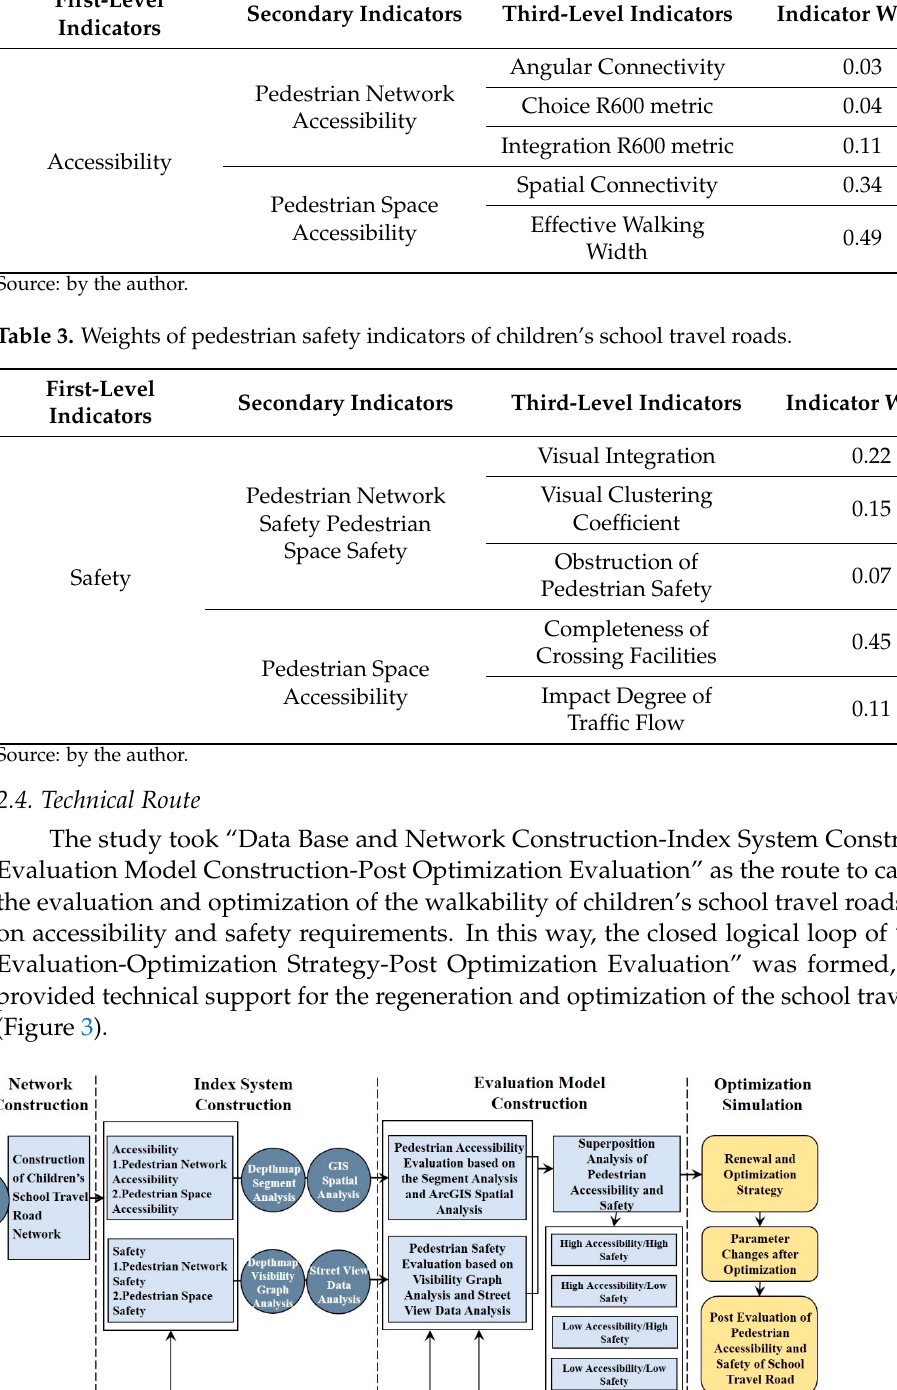
Table 2. Weights of pedestrian accessibility indicators of children’s school travel roads.